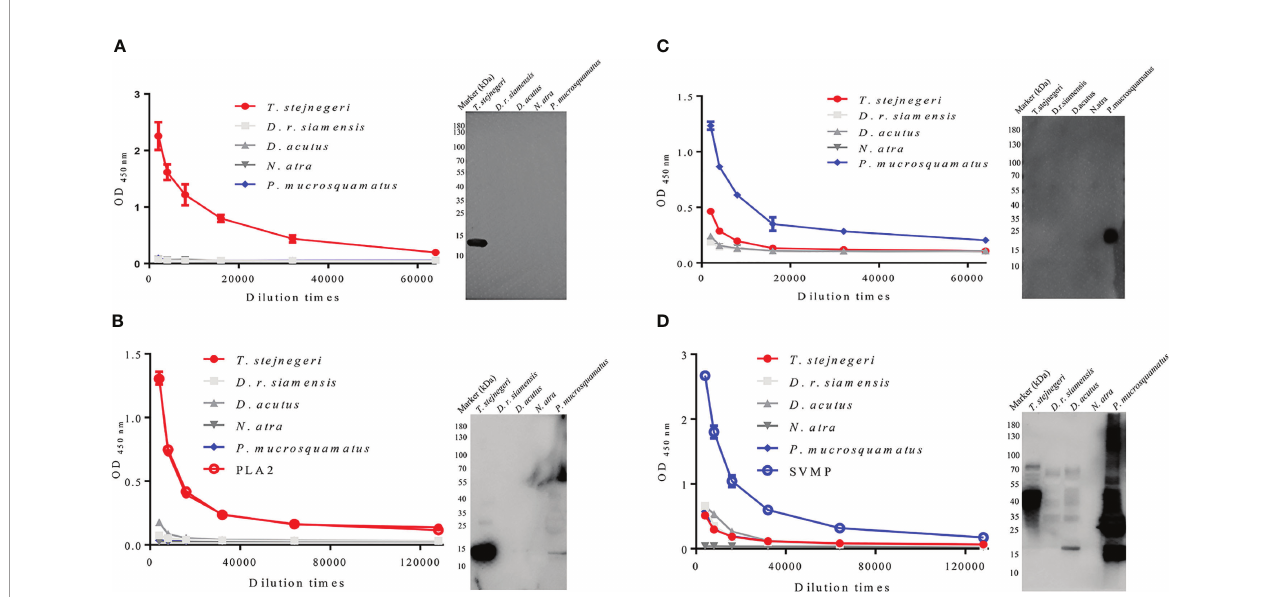
FIGURE 5 | Antigen speci fi city of mAbs-n and pAbs-n from mice and rabbits. mAbs-n and pAbs-n against natural PLA 2 and SVMP protein antigens were prepared by immunizing mice and rabbits with natural PLA 2 and SVMP protein antigens, respectively. Speci fi city and accessibility of PLA2-pep-3 were veri fi ed by mAbs-n (PLA2-mc8) (A) . Speci fi city and accessibility of SVMP-pep-1 were veri fi ed by mAbs-n (SVMP-mc4) (C) . The pAb titers of anti-PLA 2 and anti-SVMP antibodies determined by ELISA were higher than 1:128,000. ELISA and Western blotting showed that anti-PLA 2 pAbs-n had good speci fi city, while anti-SVMP pAbs-n had lower speci fi city with obvious cross-reaction with T. stejnegeri , D. r. siamensis , and D. acutus venom (B , D)